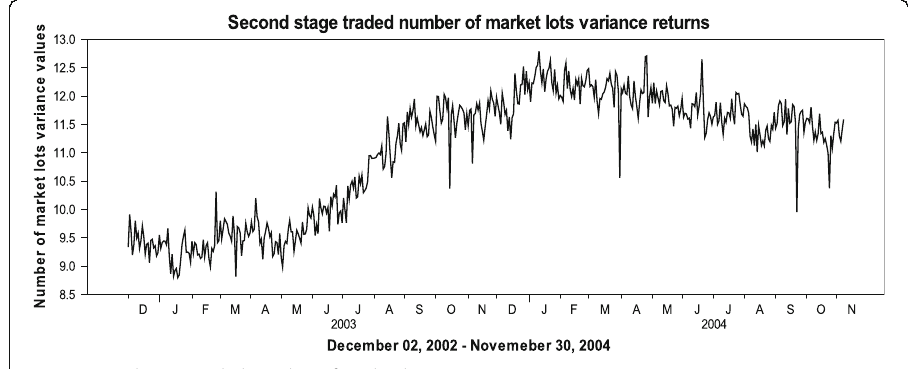
Fig. 3 Second stage traded number of market lots variance